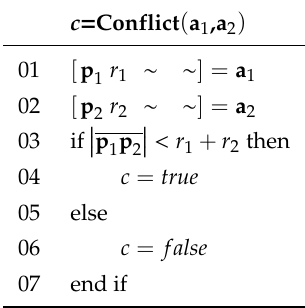
Table 1. Conflict detection